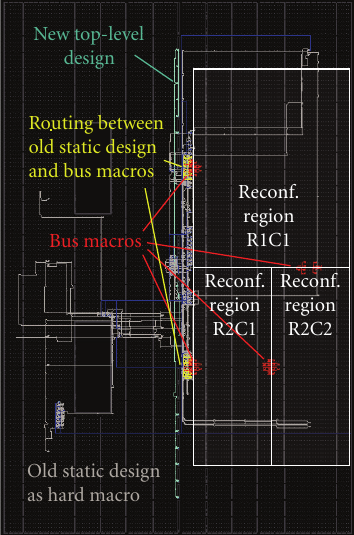
Figure 7: Static design of S 2 with static design from S 1 instantiated as a hard